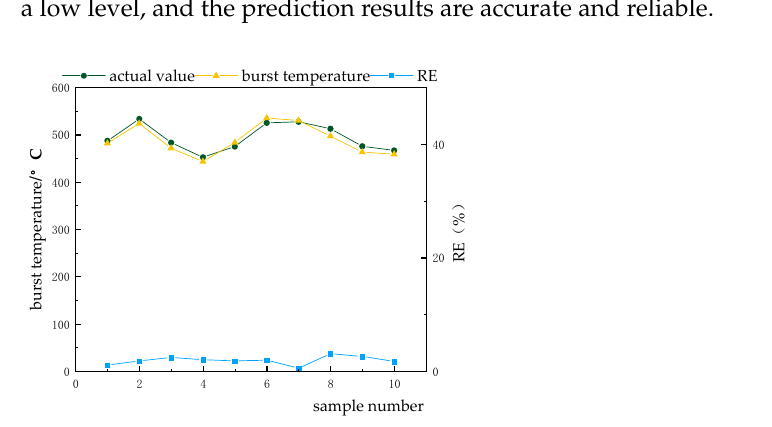
Table 9. Comparison of burst temperature prediction results.